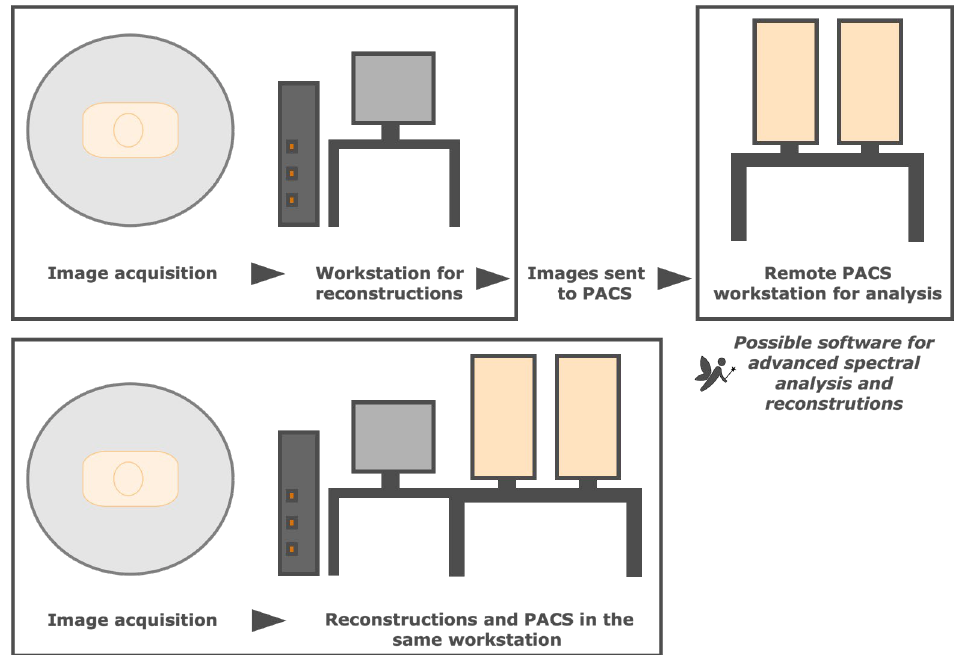
Figure 10. Different DECT workflow algorithms. Necessary reconstructions may be manually generated after the acquisition and the images sent to the picture archiving and communication system (PACS) for remote analysis at a different station (top representation), which may be complemented with advanced software that allows spectral CT analysis and reconstructions. alternatively, most vendors provide lighter workstation versions in the same computer as PACS (bottom representation), requiring a high level of vendor-specific scanner knowledge.